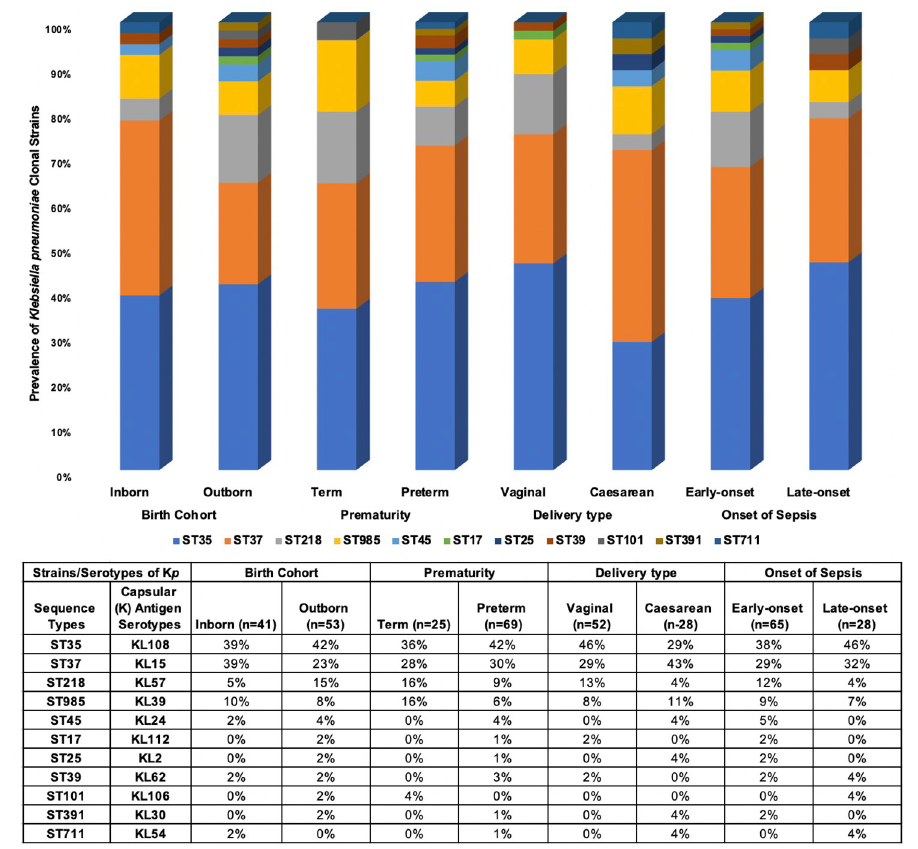
Fig 5. Distribution of the clonal strains of Klebsiella pneumoniae by location of birth (inborn or outborn). The incidence of ST35 was similar for inborn and outborn newborns, however the incidence of ST37 was twice as high among inborn (33%) compared to outborn (17%) newborns. The incidence of ST218 was three times as high among outborn (15%) compared to inborn (5%) newborns.